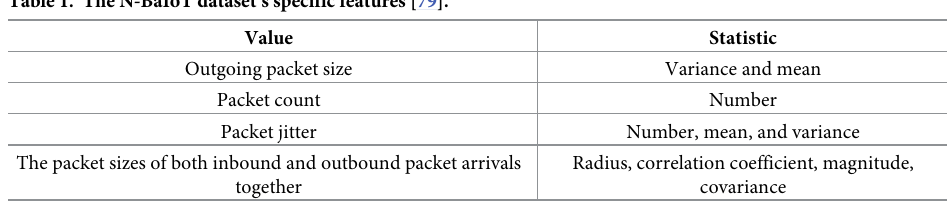
Table 1. The N-BaIoT dataset’s specific features [79]. Value Statistic Outgoing packet size Packet count Number Packet jitter Number, mean, and variance The packet sizes of both inbound and outbound packet arrivals Radius, correlation coefficient, magnitude, together